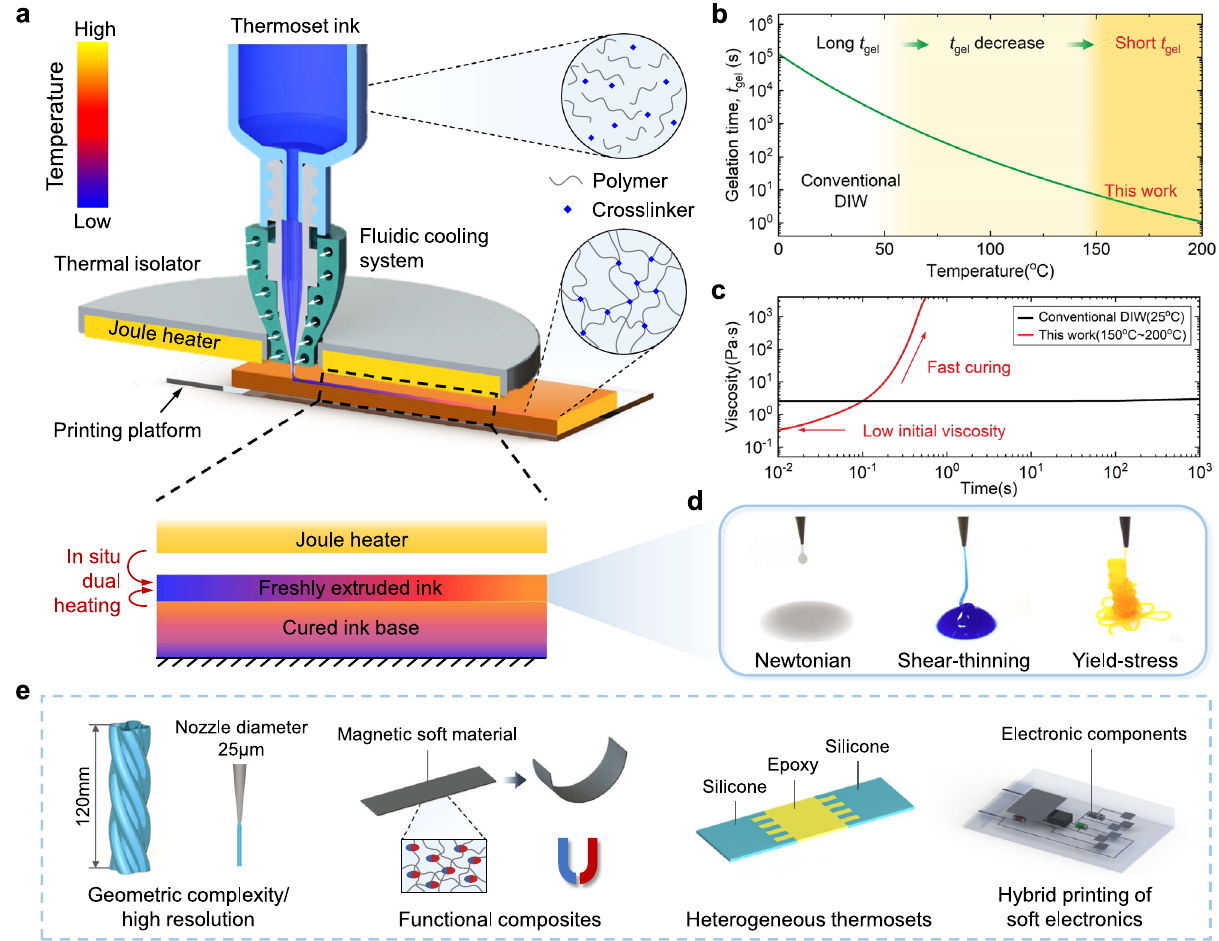
Fig.1|Overviewofinsitudualheating-enabledDIWofthermosets.a Schematic illustrationoftheDIWplatforminwhichaJouleheaterisintegratedintothenozzle. The freshly extruded ink undergoes in situ gelation as being heated bilaterally by the Joule heater and the cured ink base, referred to as in situ dual heating (ISDH). b Thegelationtimeatdifferenttemperaturesofarepresentativethermosettingink (Sylgard184). c Comparisonofviscosityasafunctionoftimebetweenconventional